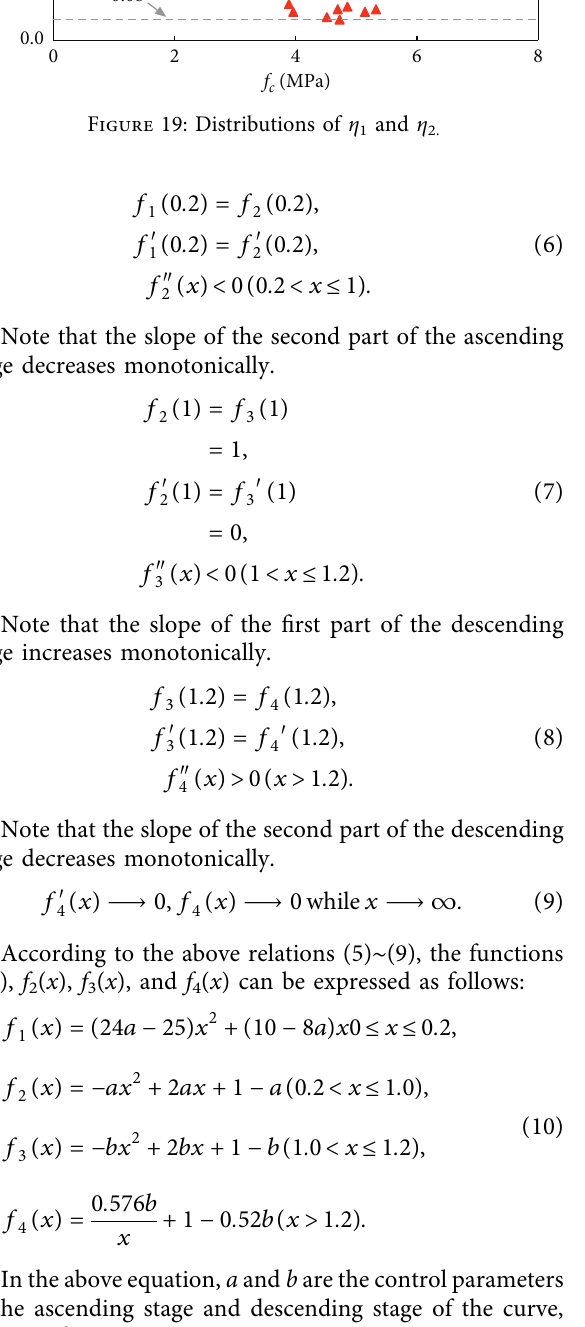
Figure 19: Distributions of η